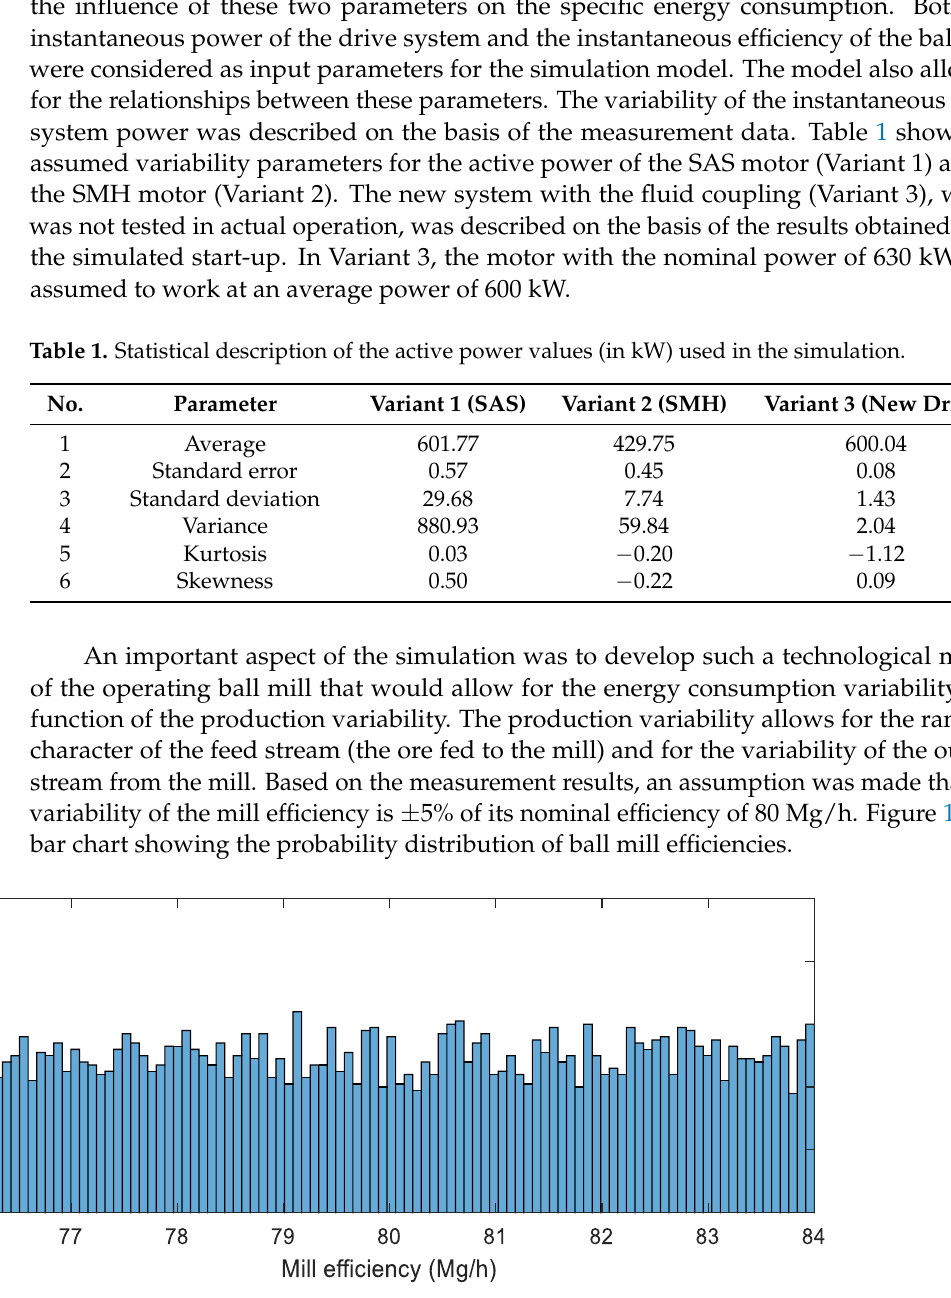
Figure 12. Algorithm of the Monte Carlo simulation.